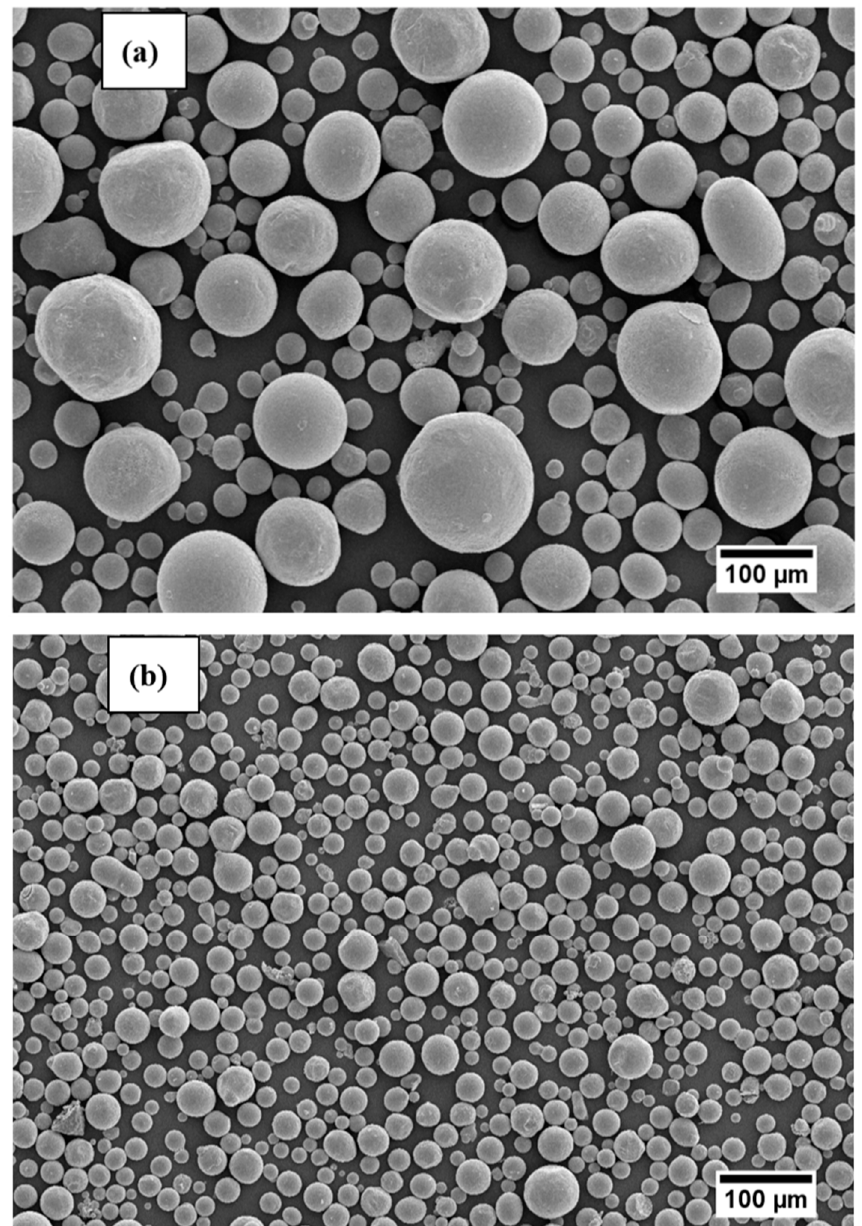
Figure 11. SEM micrographs of SAC305 lead-free solder powder products from turbo air classification experiments using an air inlet velocity of 8.5 m/s, rotor speed 619 RPM, and feed rate 4 kg/h; ( a ) coarse product and ( b ) fine product.